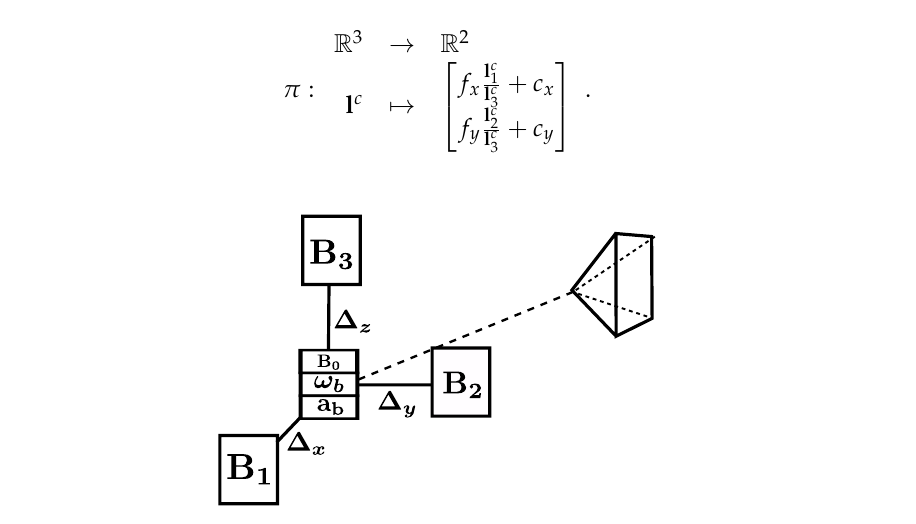
Figure 2. Schematic view of on-board sensors. In addition to accelerometers and gyrometers, the MIMU includes several magnetometers: a central one and at least three peripheral ones in order to compute the full 3 3 matrix of magnetic field gradients. The camera is rigidly attached to the MIMU ×